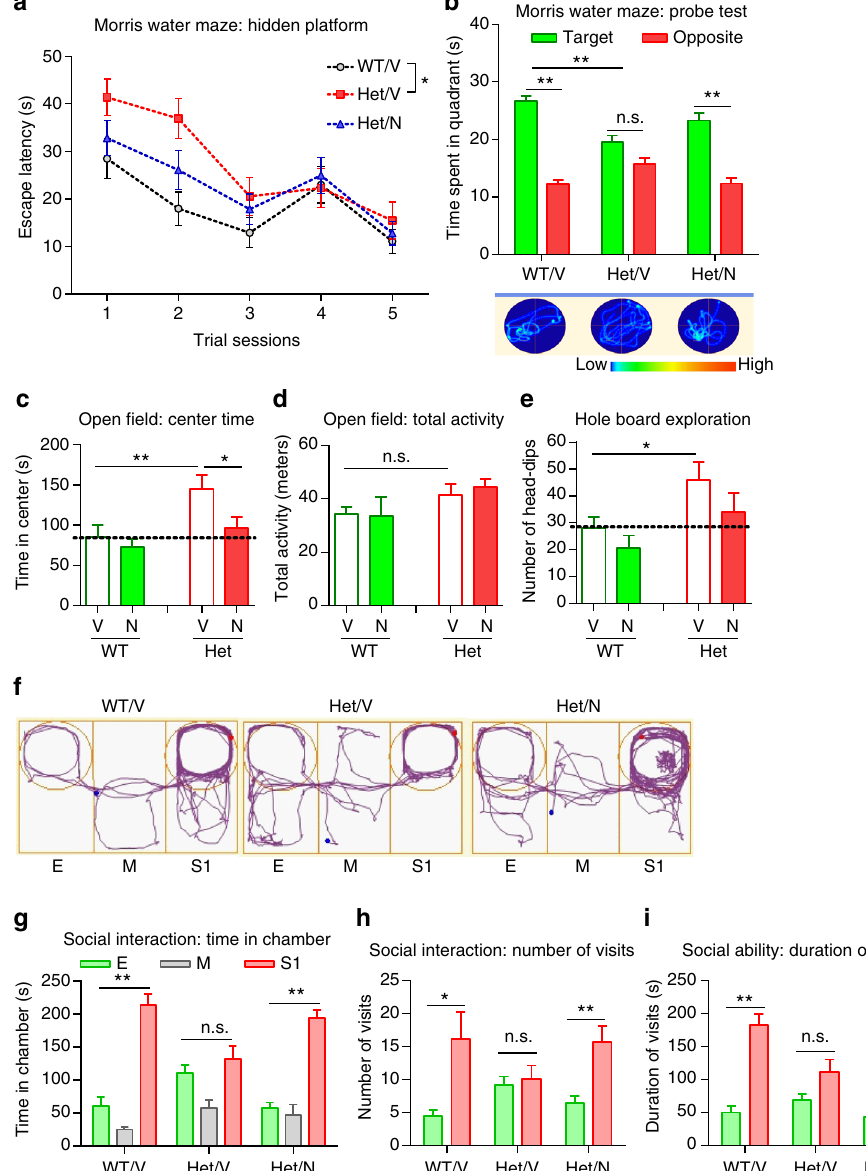
Fig. 6 NitroSynapsin rescues MCHS-like phenotypes in Mef2c -het mice. a Latency of fi nding hidden platform during training sessions in the Morris water maze. b In the probe test, vehicle-treated Mef2c -het mice (Het/V) showed no preference between target and opposite quadrants, suggesting impaired memory. Treatment with NitroSynapsin (N) rescued this effect (Het/N). Representative swim patterns shown at bottom. c , d In the open fi eld test, Het/V mice exhibited increased center time that was rescued by treatment with N ( c ). In contrast, Het/V mice displayed normal total activity ( d ). e Het/V mice displayed increased head-dips per hole, suggesting repetitive behavior. Treatment with N rescued. f – i N treatment rescued aberrant social ability in Mef2c - het mice. f Representative traces of mouse movement in the three-chamber social ability test. g – i Mef2c -het mice (Het/V) exhibit abnormalities in social interaction measured by time spent in each chamber ( g ), number of visits ( h ), and duration of visits ( i ) to E (empty) or S1 (stranger mouse 1) chambers. N treatment ameliorated this de fi cit (Het/N). Data are mean ± s.e.m. n = 7 – 9 per group. * P < 0.05, ** P < 0.01 by ANOVA. M middle embryonic lethal by E10.5 due to incomplete cardiac morpho- mice with the new, improved NMDAR antagonist genesis 45 ; in contrast, nestin-cre-driven brain-speci fi c Mef2c -KO NitroSynapsin 34 – 36 not only corrects E/I imbalance, but also mice exhibit reduced viability similar to that observed in the improves autistic/MCHS-like behavioral de fi cits, thus providing present study in Mef2c -hetmice 10 . It is thus possible that dysre- target validation and potential disease treatment. gulation of MEF2C activity in the central nervous system (CNS) is at least partially responsible for the increased lethality of Mef2c - het mice. The Mef2c -het mice that survive to adulthood exhibit a antine, but rather a novel aminoadamantane nitrate. The dual- reduced number of neurons and synaptic impairment, speci fi cally functional drug acts both as an NMDAR open-channel blocker E/I imbalance caused by reduced inhibitory and enhanced exci- and redox modulator; in fact, the aminoadamantane moiety tatory neurotransmission. Importantly, treatment of Mef2c -het